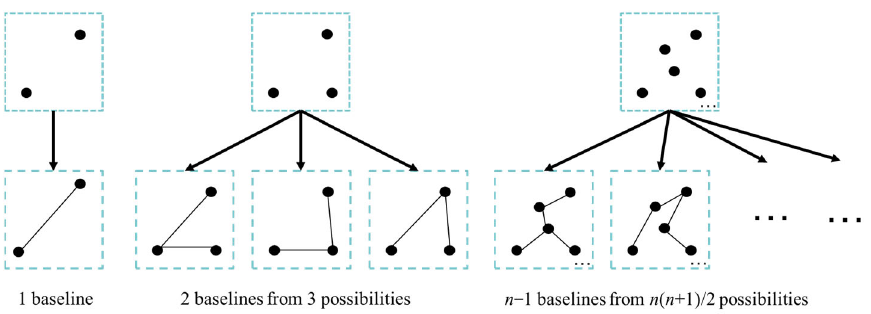
Figure 1. The schematic diagram for selecting the minimum spanning tree from all possibilities.